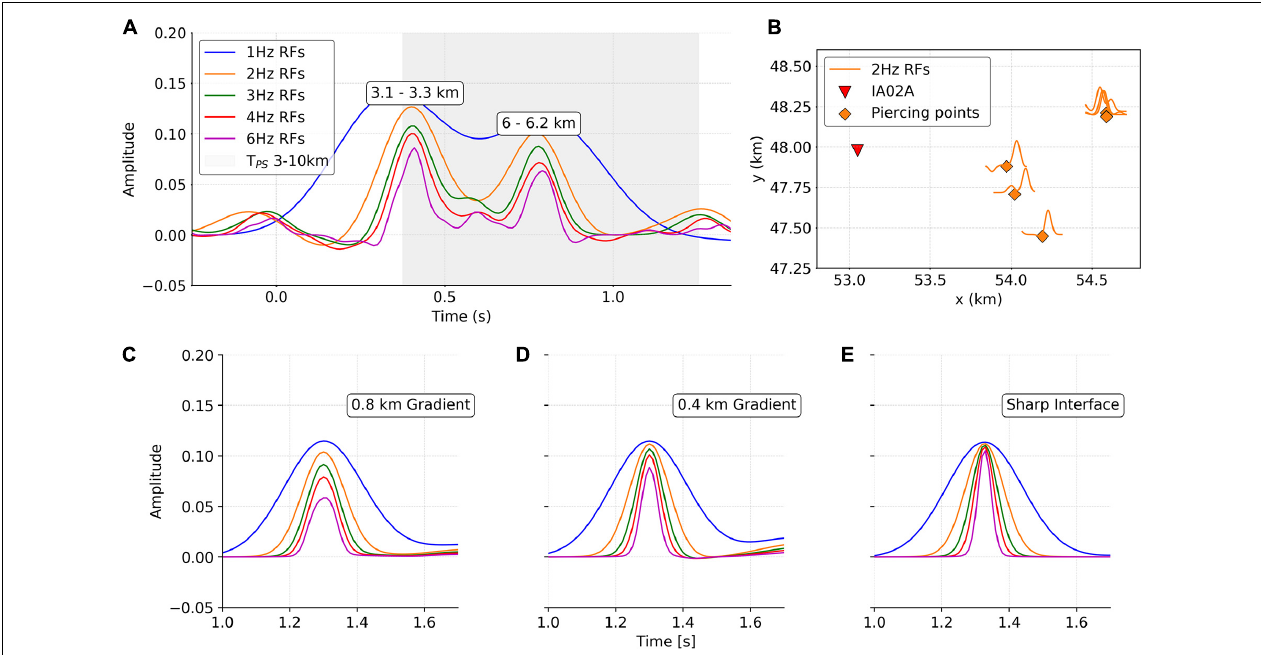
FIGURE 10 | Investigating the sharpness of the seismic interface by frequency-dependent analysis of the highest quality RFs near station IA02A. (A) Observed RFs stacked at different frequency ranges, from 0.1 Hz to five different maximum frequencies as specified in the legend. The decreasing signal width, with increasing frequency, points toward a discontinuity sharper than the resolution of the highest frequency waves. The gray band in the background indicates the expected time delay for a P-to-S converted phase from a discountinuity located between 3 and 10 km depth, and with vs = 3.5 km/s above it. The estimated depth of the conversion for the two observed peaks is indicated. For this analysis, a stricter quality control has been applied and only the RFs qualifying at all frequency ranges have been considered. (B) Piercing point map (orange squares) for the traces that have been considered in (A) , for the frequency range 0.1 Hz to 2 Hz. Next to each piercing point, the time interval 0 to 1s of the associated RFs is plotted, to highlight the spatial variability of the stacked RFs signals. (C–E) Synthetic RFs for the same frequencies as in (A) demonstrating the effect of velocity gradient sharpness on peak widths and amplitudes.